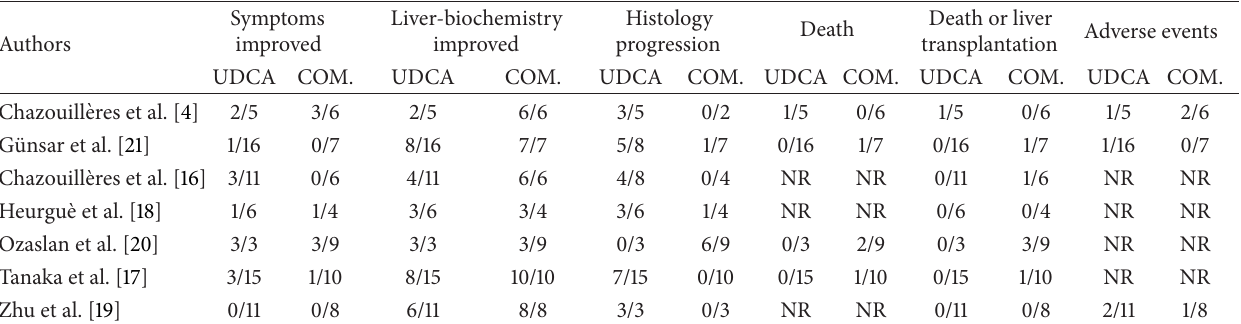
Table 4: Descriptive results of the randomized trials.